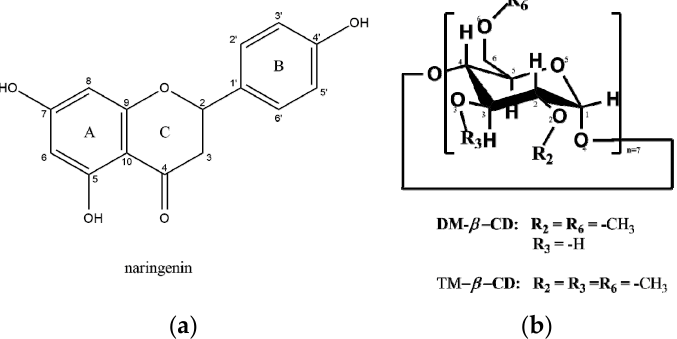
Figure 1. Schemes of ( a ) naringenin and ( b ) heptakis (2,6-di- O -methyl)- β -cyclodextrin (DM- β -CD) and heptakis (2,3,6-tri- O -methyl)- β -cyclodextrin (TM- β -CD).